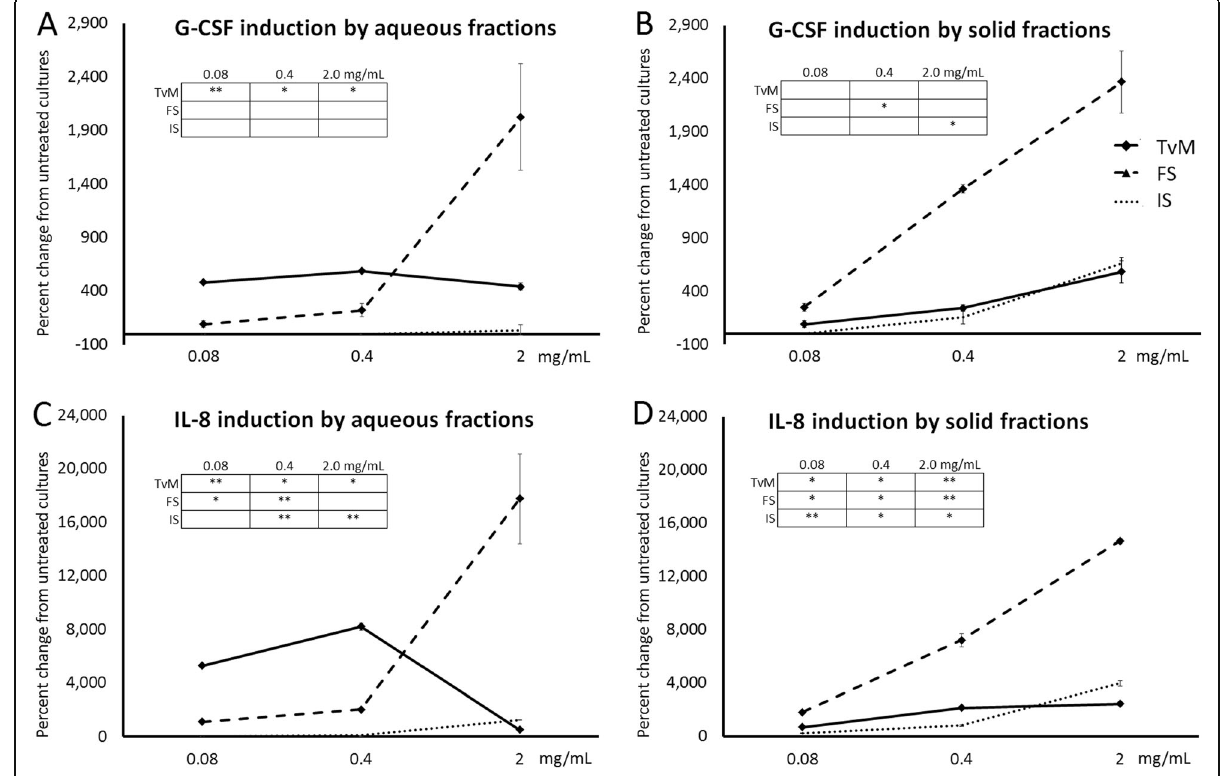
Fig. 8 Changes in levels of the growth factor Granulocyte-Colony Stimulating Factor (G-CSF) and the cytokine Interleukin-8 in supernatants from human PBMC cultures. The PBMC were cultured for 24 h in the presence of serial dilutions of Trametes versicolor mycelium (TvM), fermented substrate (FS), or initial substrate (IS). The effects on the stem cell mobilizing growth factor G-CSF and Interleukin-8 (IL-8) of aqueous extracts are shown in a and c , and of the solid fractions are shown in b and d . Data are shown for three doses (0.08, 0.4, and 2 mg/mL), where the doses represent the amount of starting material used to produce a given fraction. Data are presented as mean ± standard deviation of the percent change seen in triplicate cultures and represents one of three separate experiments using PBMC cells from three different healthy human donors. Inserted tables: Statistical significance is indicated as * for P < 0.05 and ** for P <